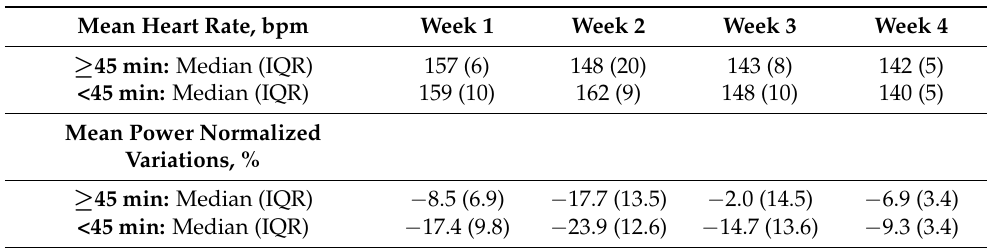
Table 3. Median values, IQR of the heart rante and mean power normalized variations for each week in the two